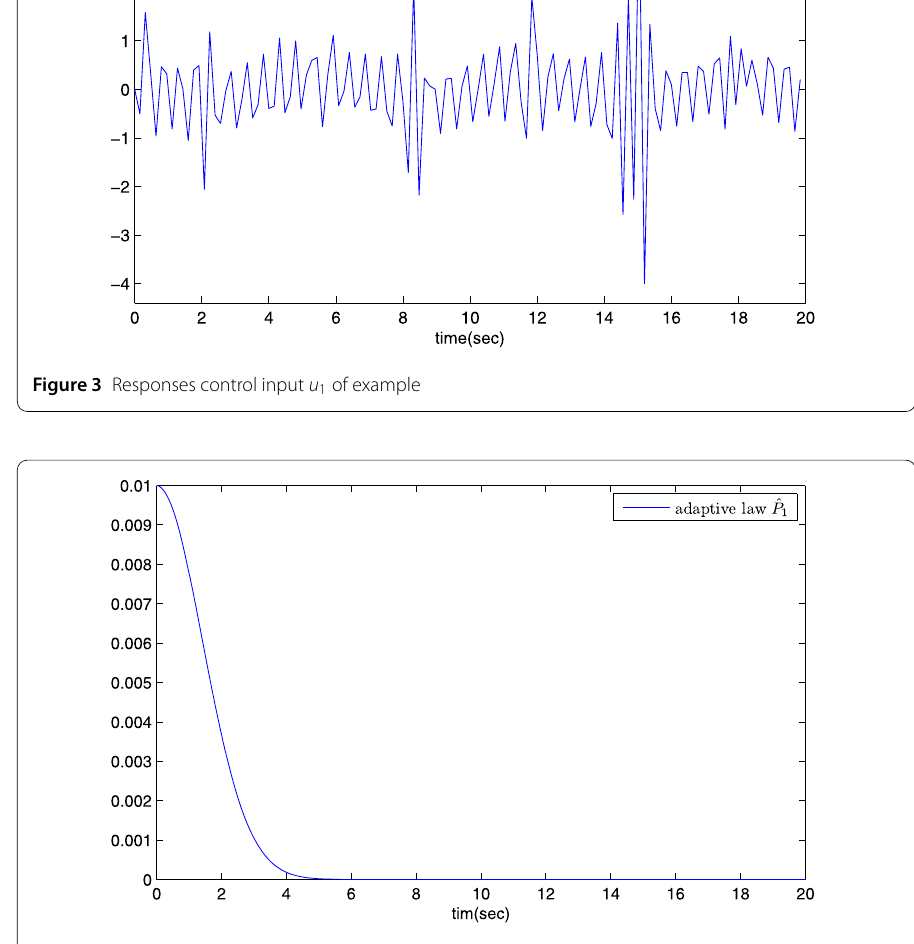
Figure 4 Responses of the adaptive laws ˆ P 1 of